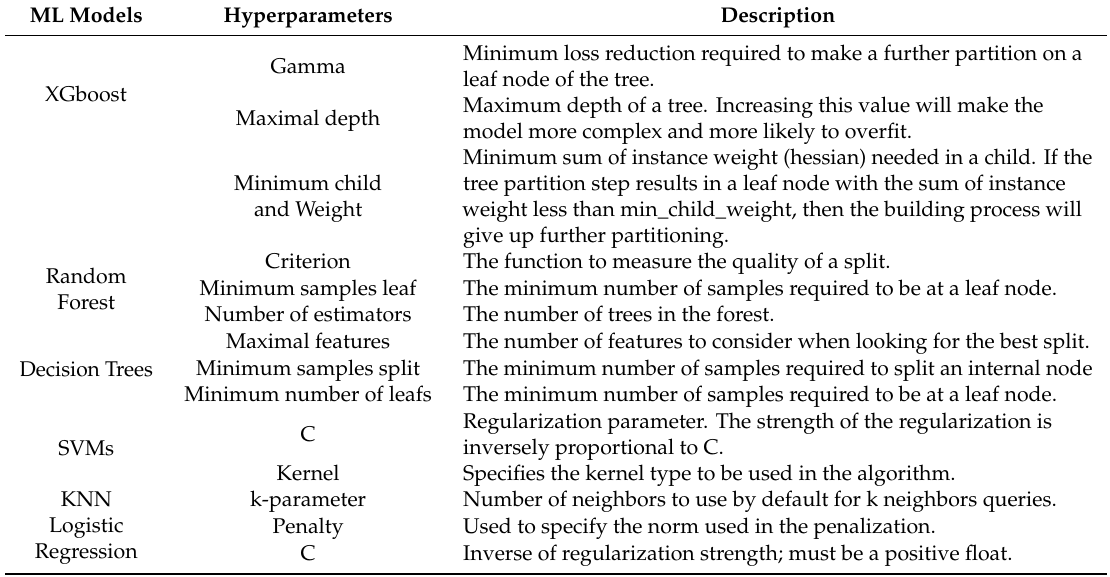
Table 2. Hyperparameters